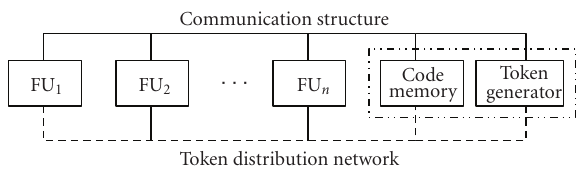
Figure 1: Abstract model of an AMIDAR